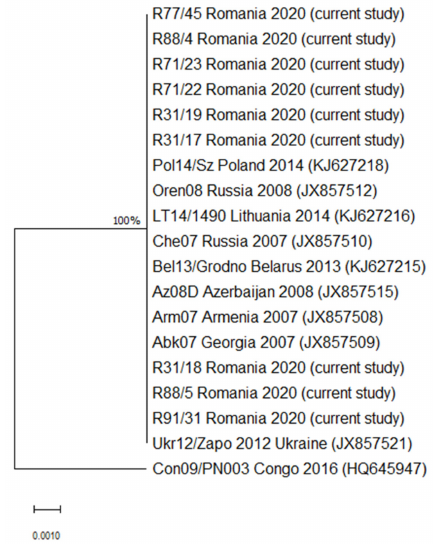
Figure 1. Maximum likelihood tree based on partial p72 B646L rDNA sequences obtained in the current study and sequences of ASFV genotype II (GenBank). Only bootstrap values above 75% are displayed. The scale bar indicates the number of nucleotide substitutions per site. The Gen-Bank accession number, assigned name, and country of origin are indicated for each sequence, if